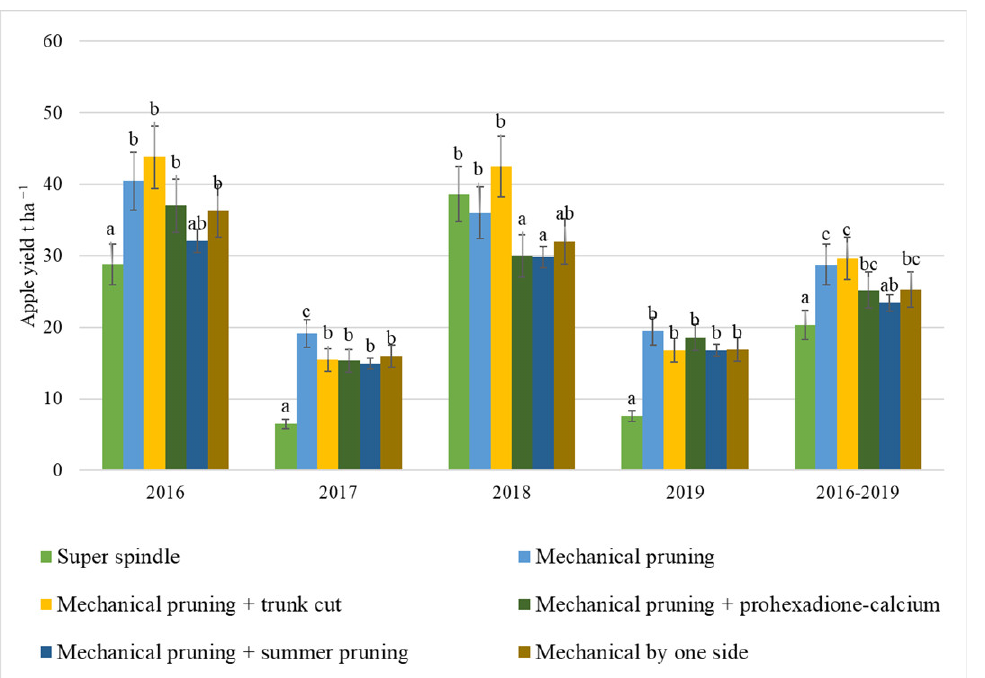
Figure 5. The effect of canopy training treatments on cv. Rubin yield 2016–2019. The mean value ( n = 3) ± standard deviation is presented. The data were processed using a two-way analysis of variance (ANOVA), the Tukey (HSD) test at the confidence level p = 0.05. The different letters in year indicate significant difference in treatment.